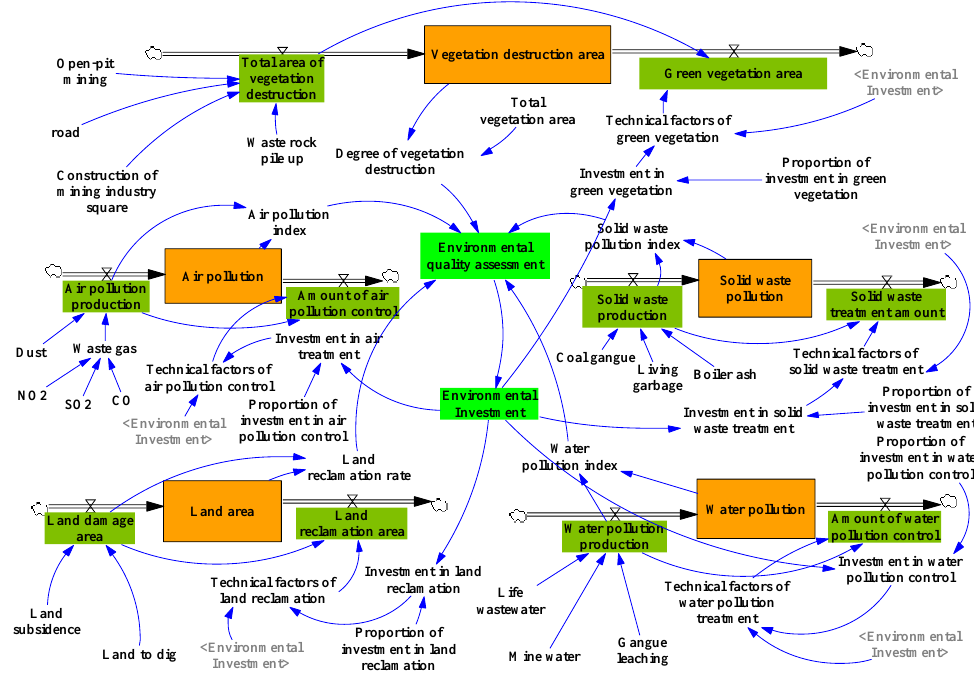
Figure 7. The system flow diagram of the general system.